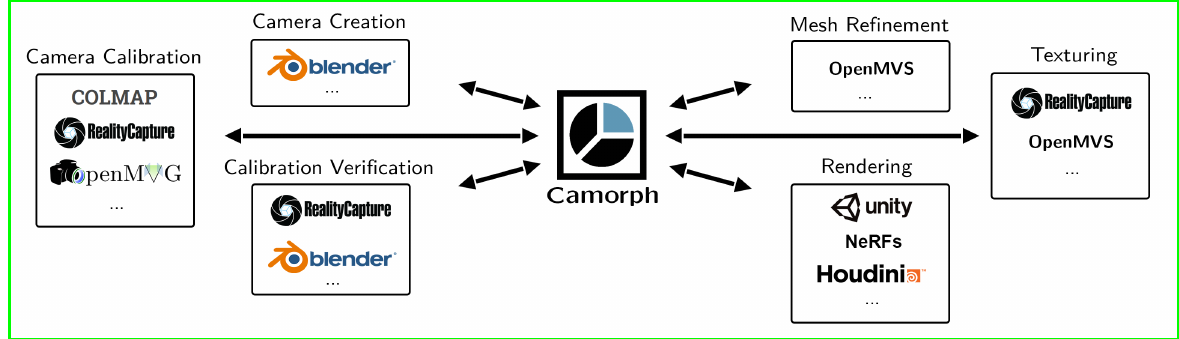
Figure 1. Potential use cases and applications for the conversion of camera parameters between formats and coordinate systems for different